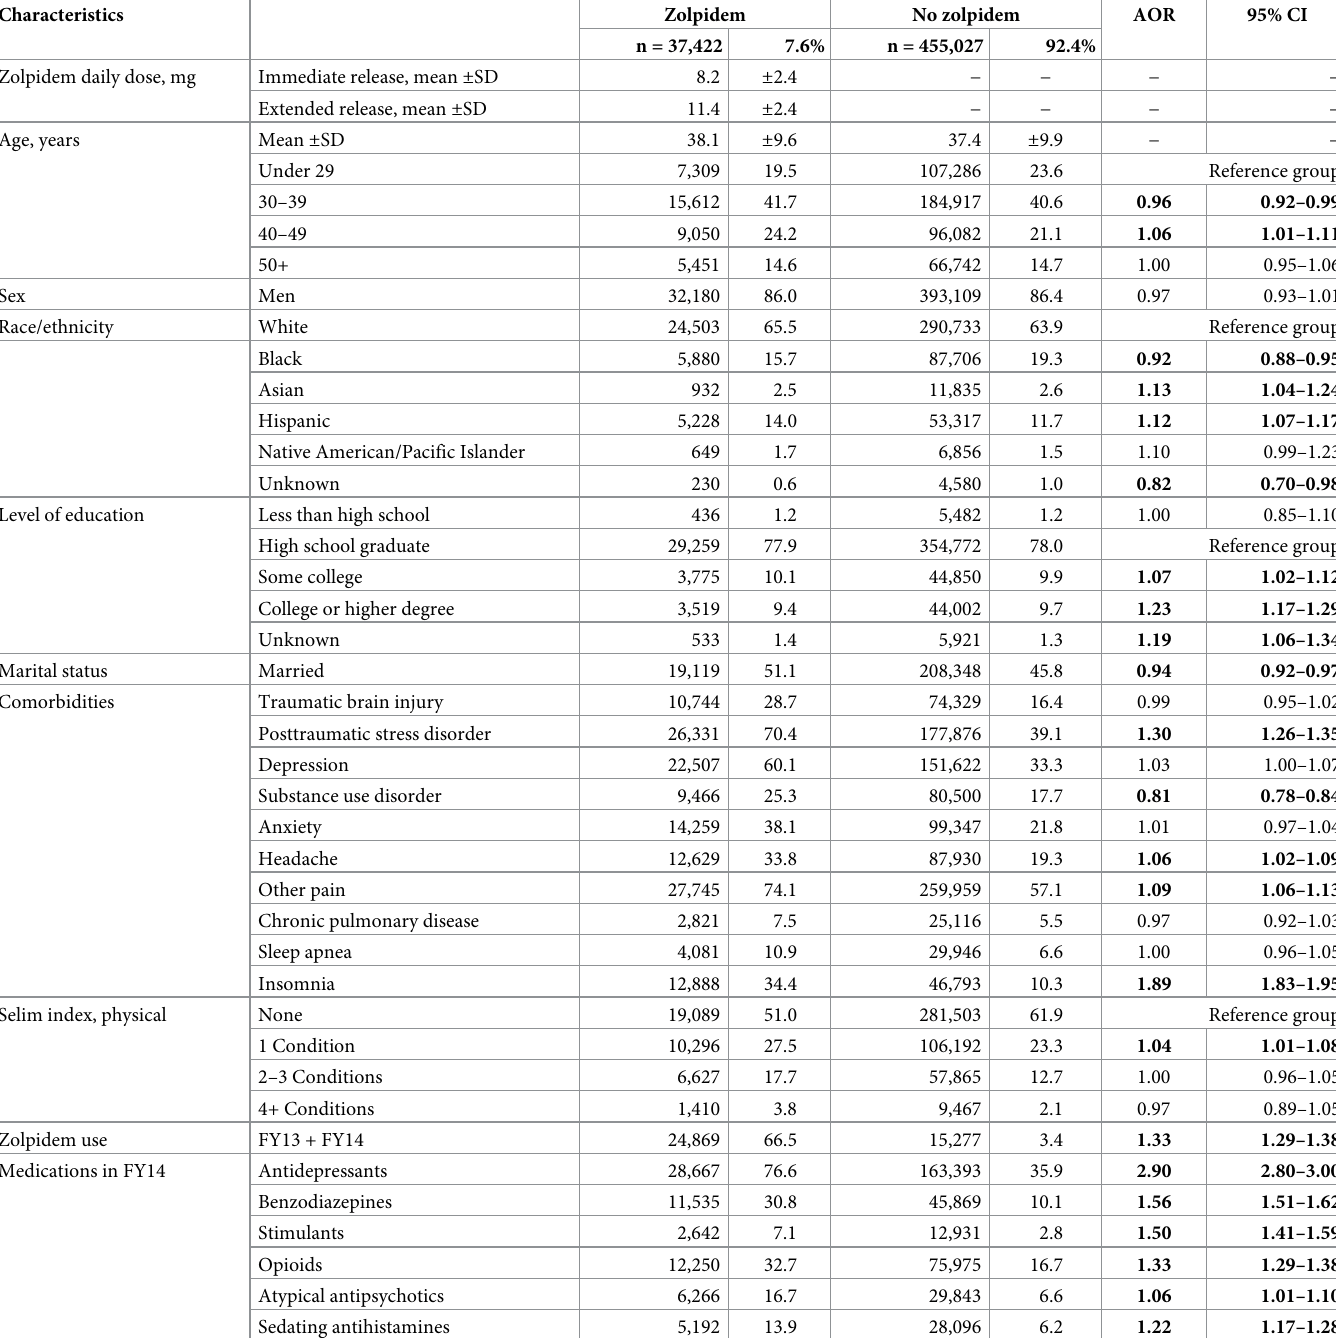
Table 1. Adjusted odds ratios (AOR) of correlates of zolpidem use among Iraq and Afghanistan veterans in fiscal year 2014.